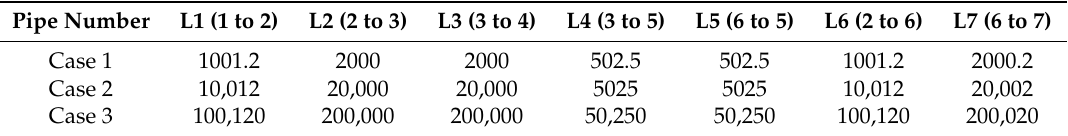
Table 2. The length of pipe for different